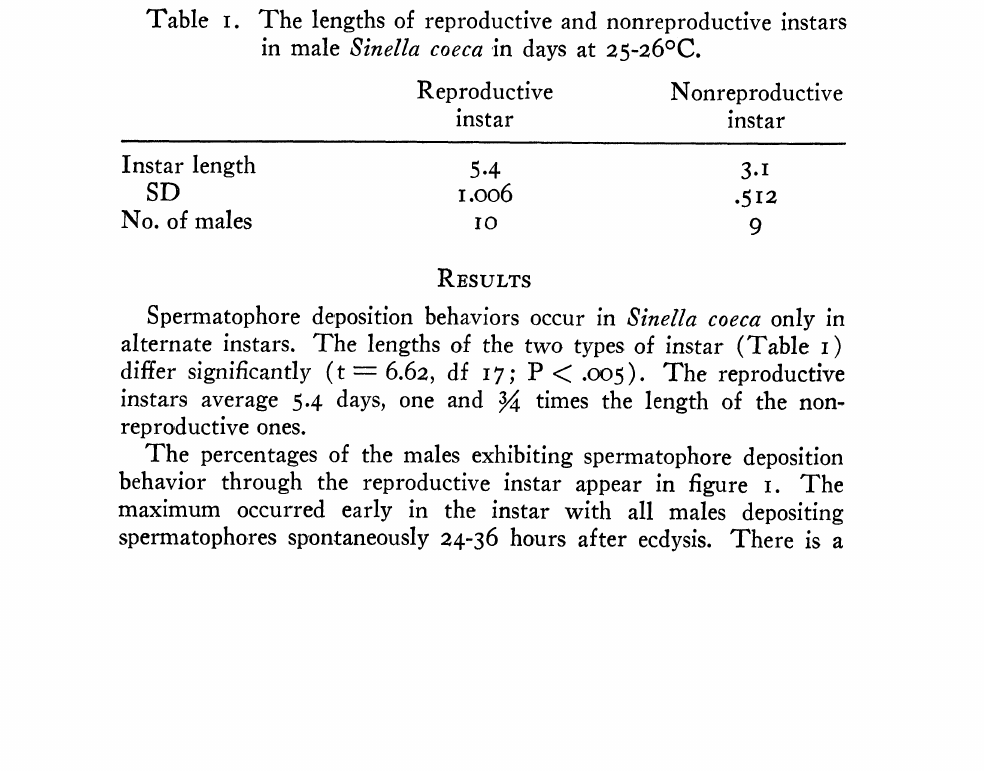
. Table The lengths of reproductive and nonreproductive instars in male 8inella cocoa ,in days at